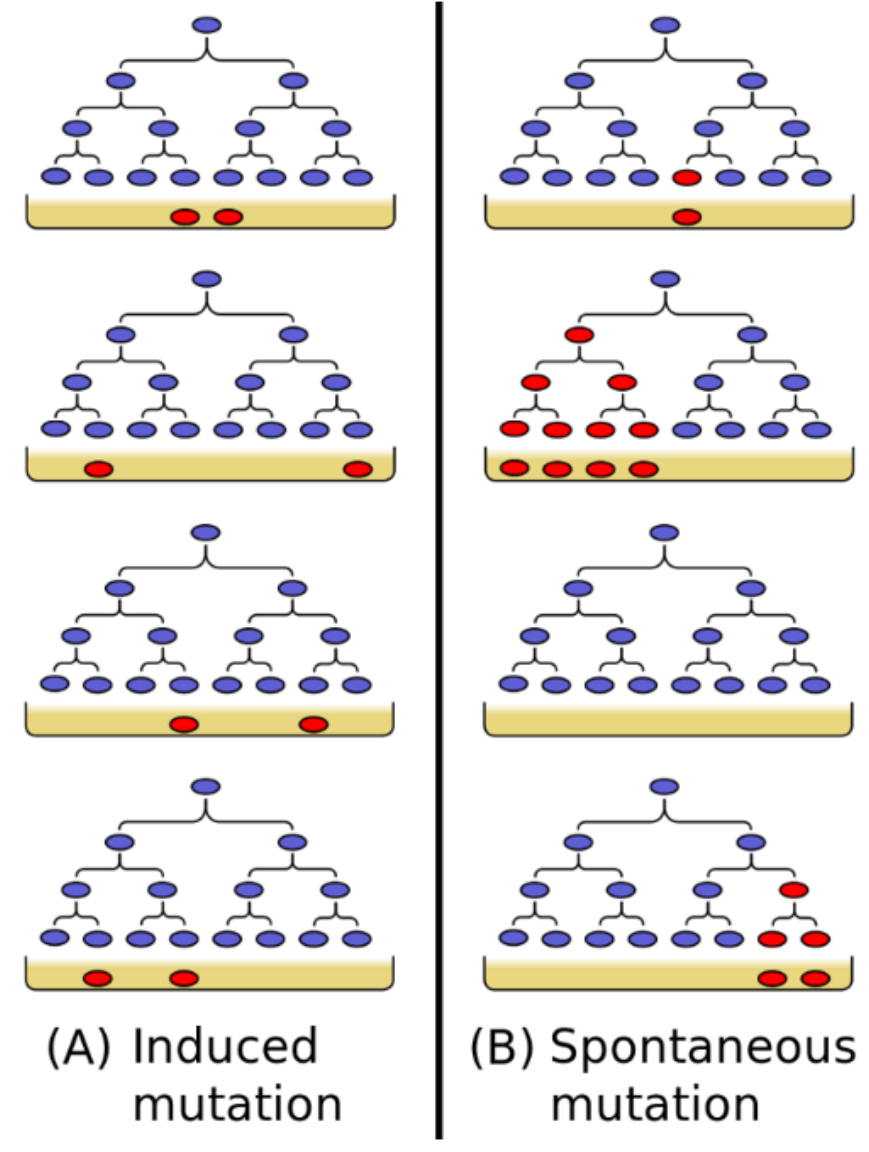
Figure 1. The Fluctuation Test was designed to distinguish between the “Lamarckian model” of the Induced Mutation Hypothesis ( A ) and the “Darwinian model” of the Spontaneous Mutation Hypothesis ( B ). In A, the bacteria were grown up in a bulk culture in the presence of a selective agent and then subdivided into aliquots after culturing. In ( B ), the bacteria were grown up in a total equal volume of fluid but in subdivided aliquots, and, post-culturing, each aliquot was exposed to the selective agent. After culturing, the mean and variance of resistant mutants in each aliquot were determined. A Poisson statistical test of the mean divided by the variance was used to distinguish which of the two hypotheses was consistent with the data. The experiment is described in more detail in Section 2.2 below. Image from Wikipedia, used under the CC